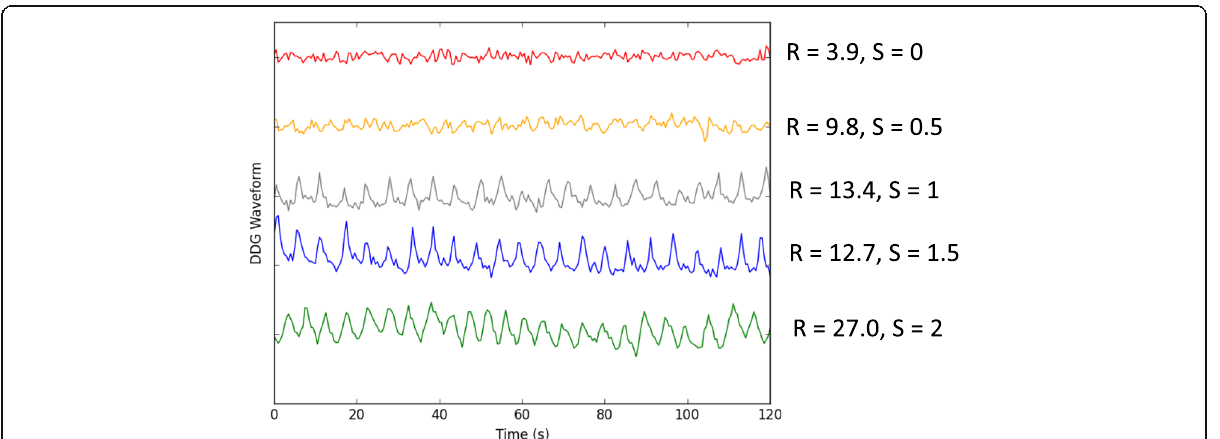
Fig. 3 Example waveforms showing the first 120 s (out of 240 s) of data for five different bed positions. The R values and mean scores S are shown for each